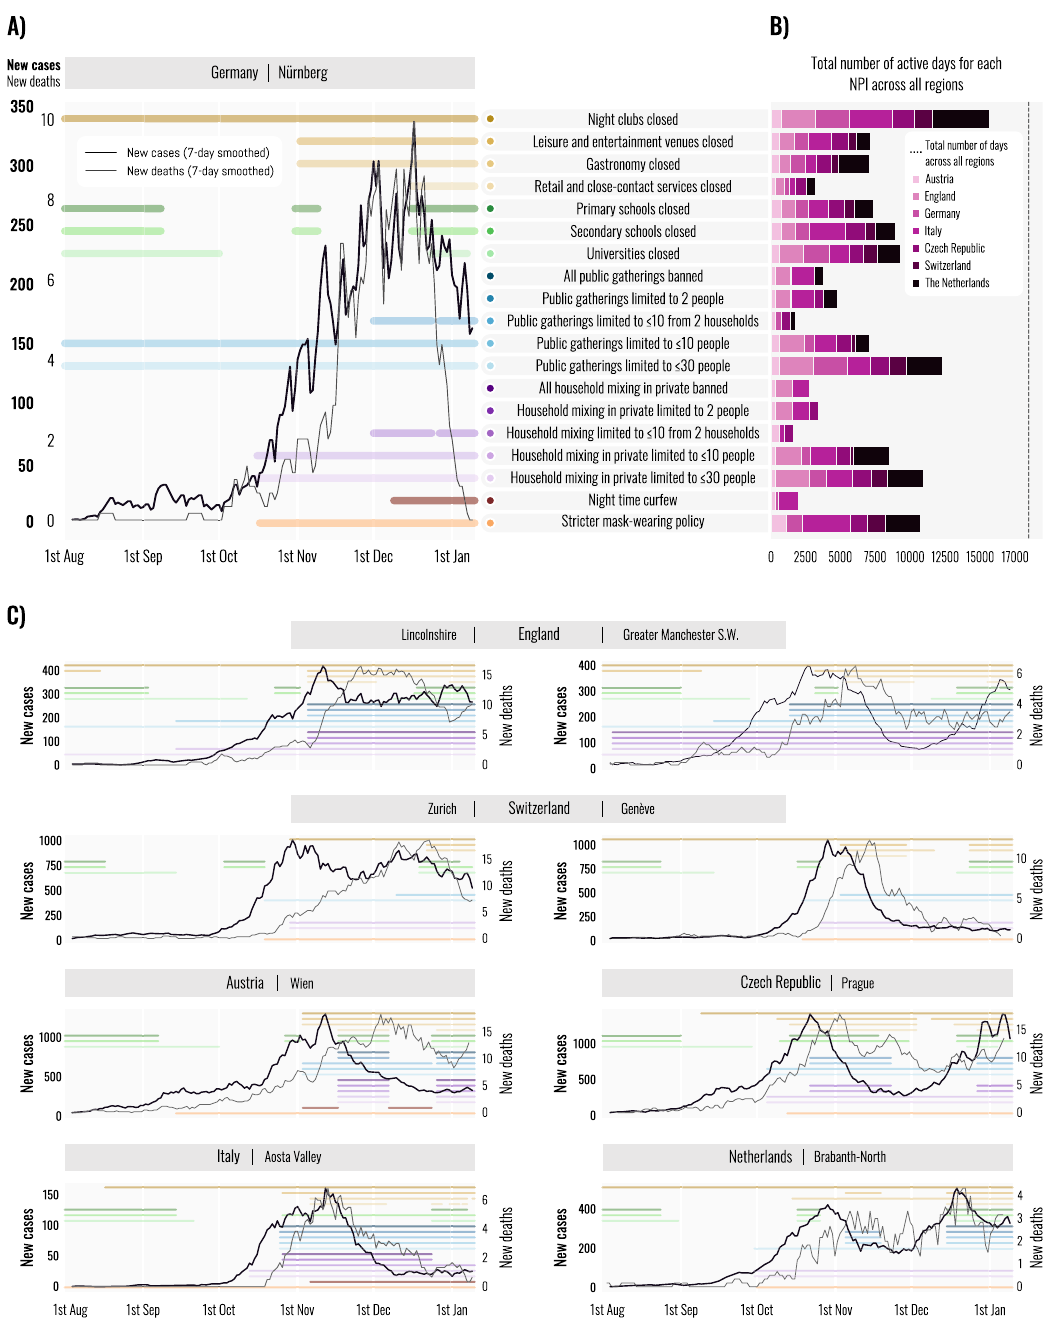
Fig. 1 Dataset. A Cases, deaths and implementation dates of nonpharmaceutical interventions in an example region (Nürnberg, Germany). Coloured lines indicate the dates that each intervention was active. Colours represent different interventions. B The total number of days that each intervention was used in our dataset, aggregated across n = 114 regions but separated by country. The dashed vertical line indicates the total number of region days in our dataset. C Additional timelines showing cases, deaths, and interventions in six regions. Comparing two regions within England (Lincolnshire and Greater Manchester S.W.) and within Switzerland (Zürich and Géneve) reveals signi fi cant subnational variation, both in the interventions used and in the evolution of the